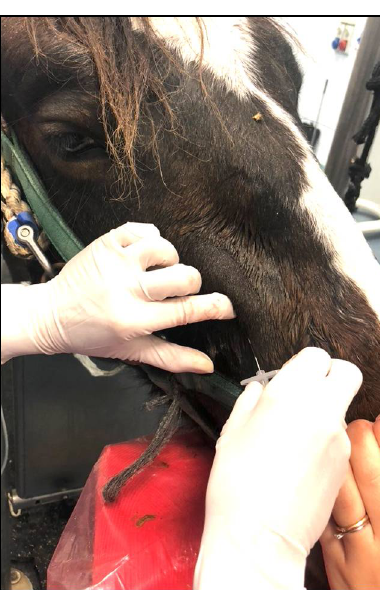
Figure 3. July 2016: a 38-day old foal in group GEN undergoing bilateral rhinoplasty for nasal septum fracture. Two 22 G × 5 cm Tuohy needles were inserted at the right ( A ) and left ( B ) infraorbital canal for bilateral block of the maxillary nerve.